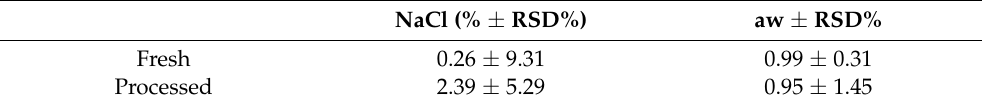
Table 1. Concentration of NaCl after the industrial